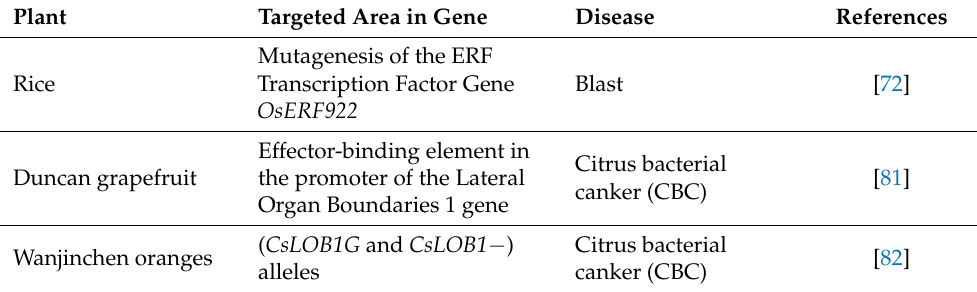
Table 6. Three examples of exploitation of CRISPR-Cas9 to counteract crop bacterial disease.